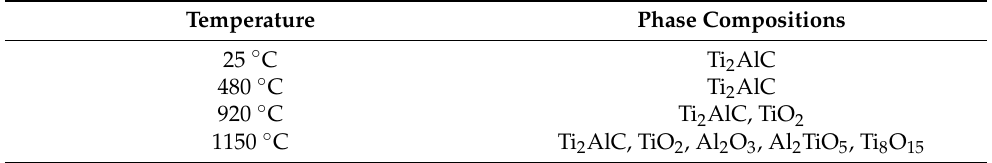
Figure 2. Energy dispersive spectrometer (EDS) patterns of Ti 2 AlC samples quenched in air at dif- ferent temperatures: ( a ) 920 °C and ( b ) 1150 °C.